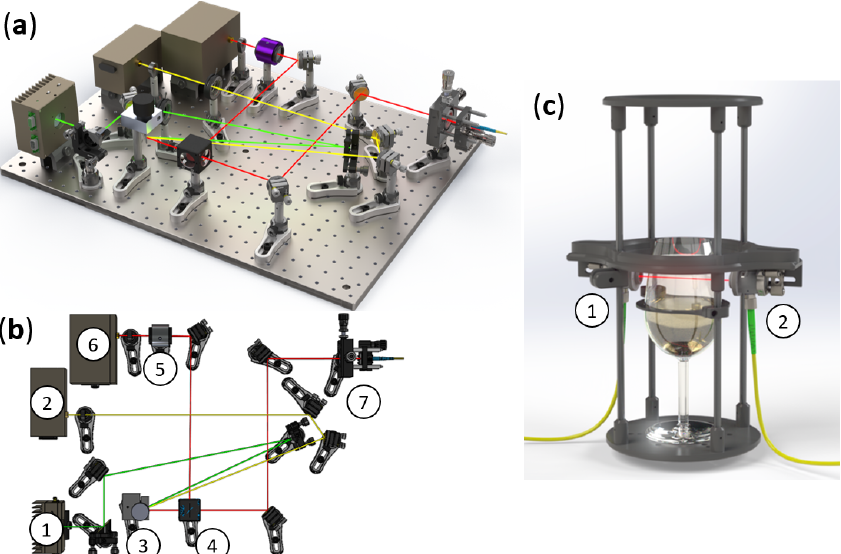
Figure 2. A 3D overview of the experimental spectrometer used for shaping and guiding the lasers’ beams ( a ). Top view of the spectrometer with the corresponding legends: (cid:192) Laser @ 2.004 µm; (cid:193) Laser @ 2.682 µm; (cid:194) Galvanometric mirror; (cid:195) Pellicle beam splitter; (cid:196) Germanium Fabry–Pérot; (cid:197) InAs photodiode; and (cid:198) Fiber coupler ( b ). The 3D-printed structure used to hold the laser beam position through the champagne glass under swirling conditions with the corresponding legends: (cid:192) Input reflective collimator; and (cid:193) Output reflective collimator ( c ). The connection between the two setups is achieved through an optical fiber.